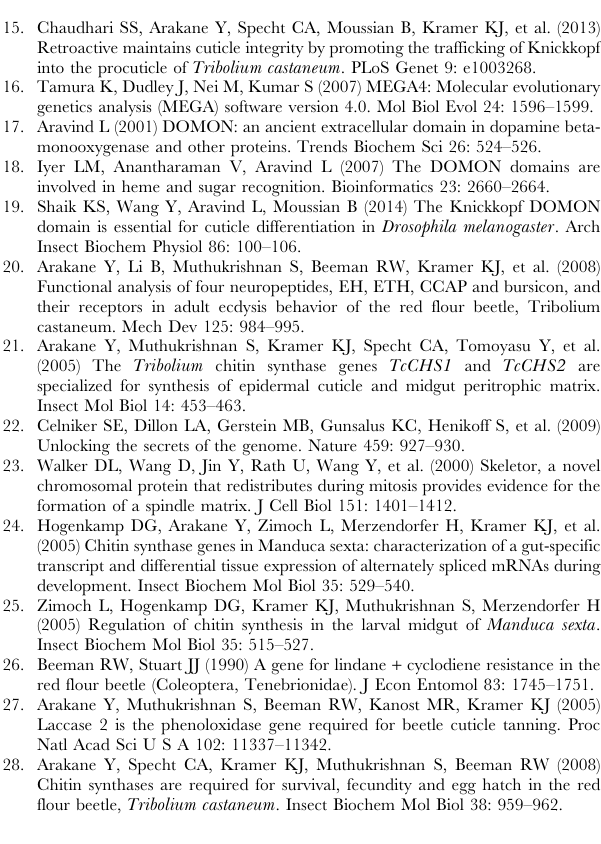
Figure S2 Amino acid sequence alignment for TcKnk3-FL-1 and TcKnk3-FL-2. Black shading of amino acid residues indicates identity. Figure S3 Sequence alignment of TcKnk-family proteins. Black and gray shading of amino acid residues indicates identity. Underlines and boxes of different colors indicate different domains: green, signal peptide; blue, DM13 domains; red, dopamine monooxygenase N-terminal like (DOMON) domain; orange underline, GPI anchor-specifying sequence; black underline, transmembrane domain. 149 amino acids were removed from the C-terminus of TcKnk3-5 9 protein for alignment. Figure S4 Specificity of dsRNA-mediated down-regulation of TcKnk3 transcripts. Levels of TcKnk3-FL and TcKnk3-5 9 transcripts after treatments with different dsRNA were determined by RT-PCR (28 cycles) using appropriate primers designed to amplify the full length or the 5 9 -TcKnk3 cDNA products. Indicated dsRNAs (labeled at the top of each panel) were injected into pharate pupal insects. Five days post- injection, RNA was collected from pharate adult insects for cDNA preparations. TcRpS6 (24 cycles) was used as an